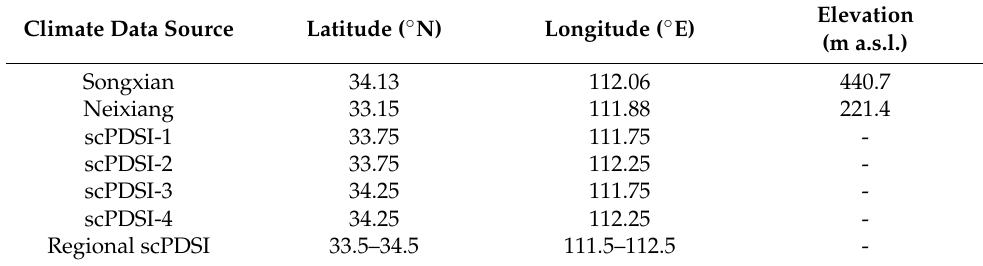
Table 1. Characteristics of climate data used in correlation analyses. Climate Data